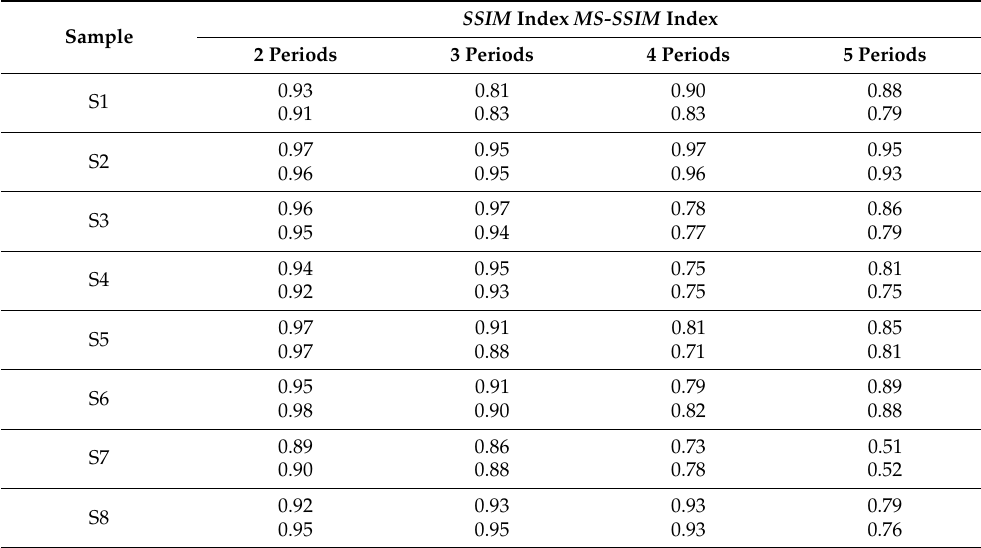
Figure 10. Phase images for the samples with the square cross section defects. A halogen lamp was used as a source of excitation. S5–S8 denotes con fi guration of the square holes.